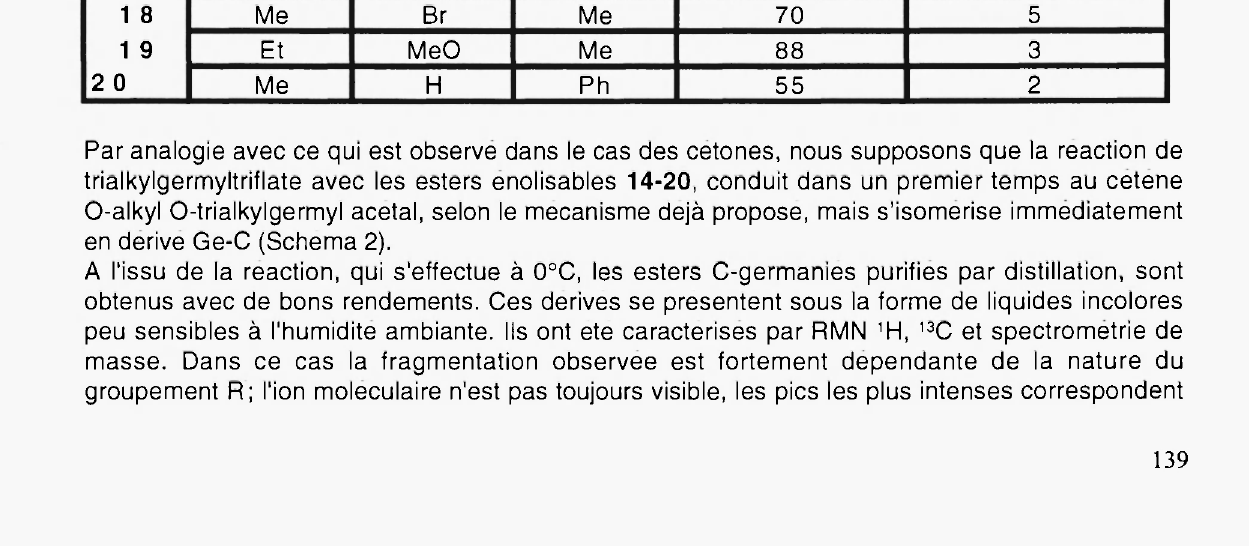
III.Germylation des esters